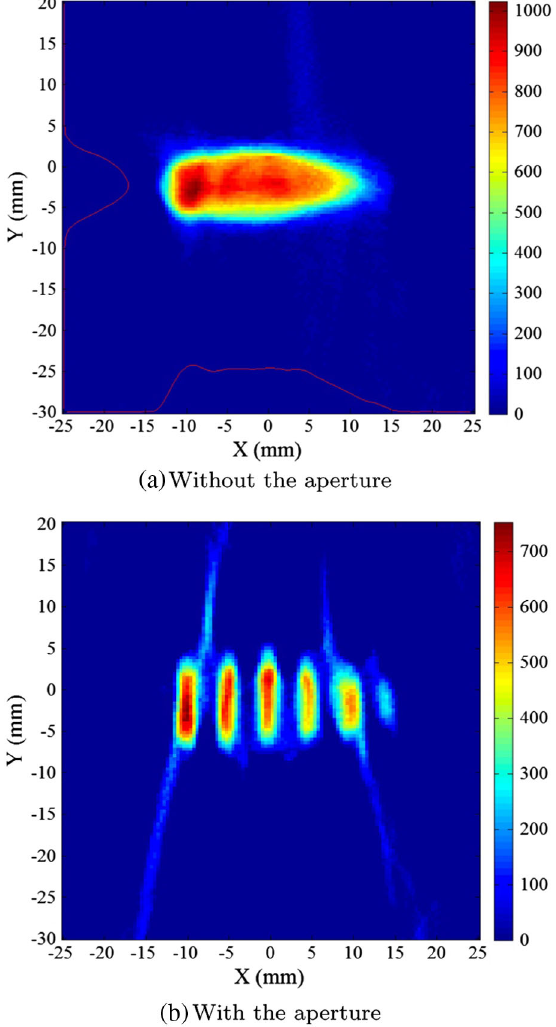
FIG. 12. Reconstructed transverse profiles of the proton beam aperture upstream the rotatable